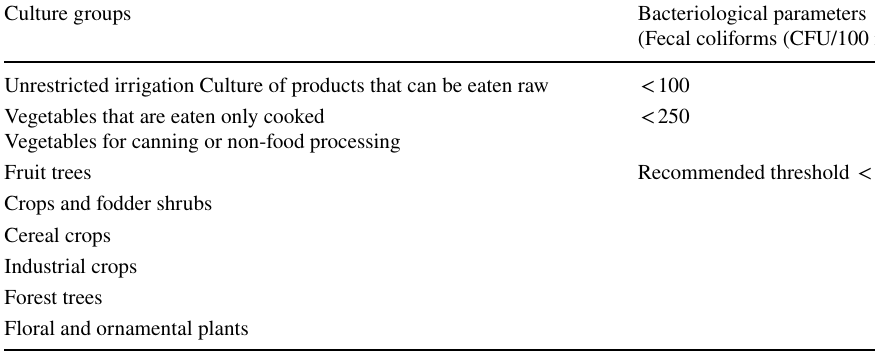
Table 4 Bacteriological specifications for purified wastewater used for irrigation purposes (Ministry of water resources and the environment of Algeria JORA n°41,